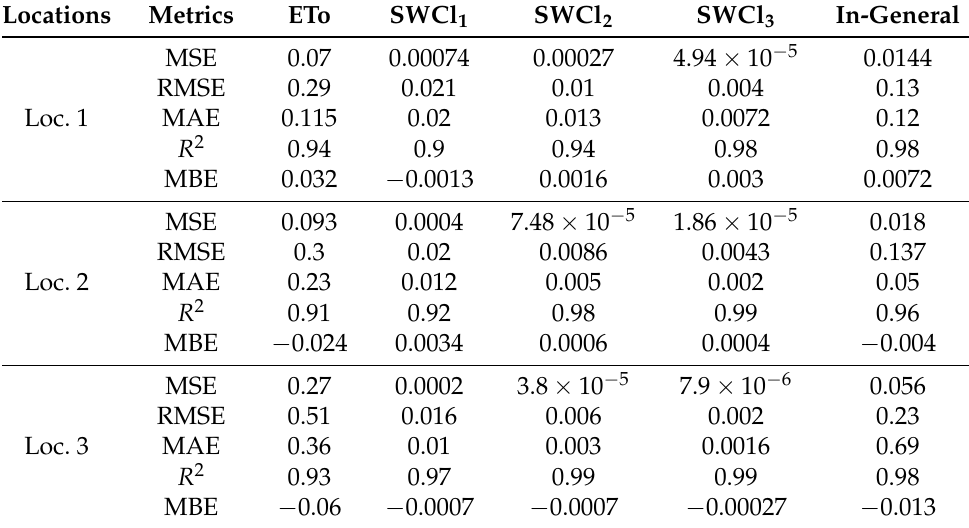
Table 5. Evaluation of the LSTM model on the test set for each location. The model was trained on all